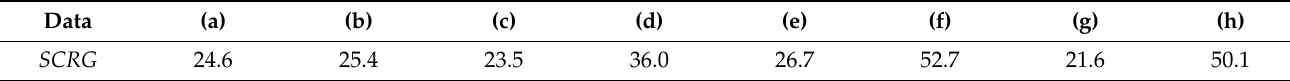
( h2 ) Figure 18. ( a1 – h1 ): operation results of “center-surround difference” applied in ITTI model. ( a2 – h2 ): the results of the “center-surround difference” operation of different scales in our model.